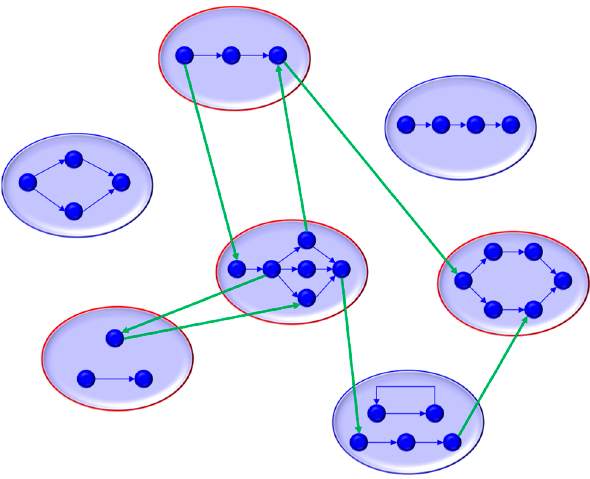
Figure 3. Two-level business model approach in CrossWork [23].